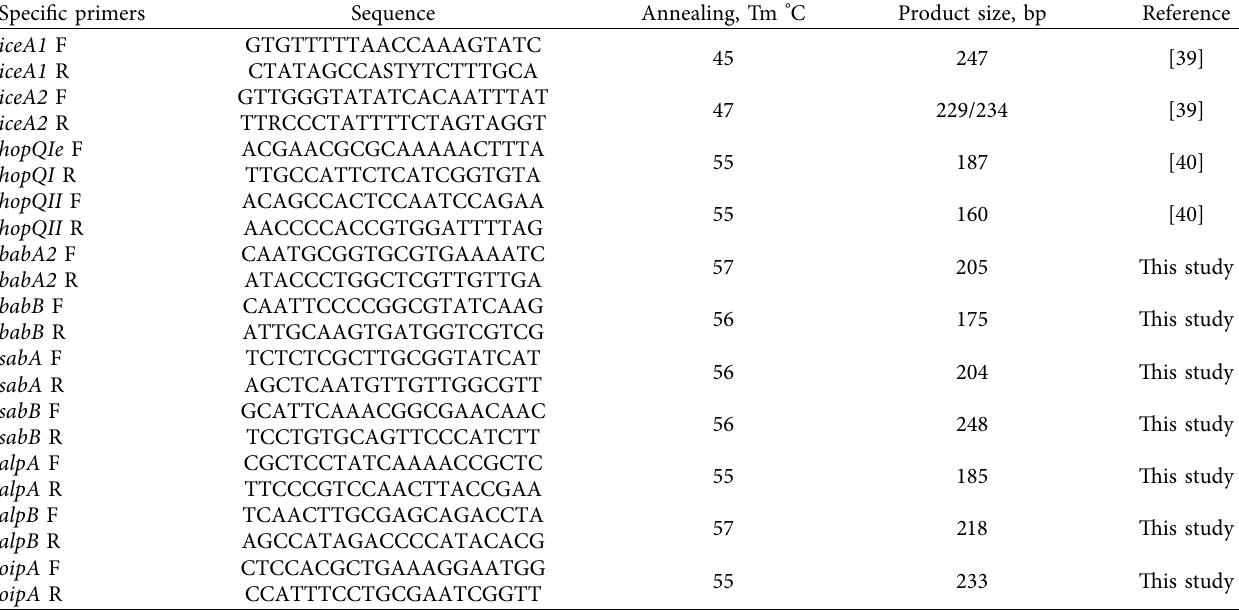
Table 2: Primers of H. pylori adhesins and surface proteins.